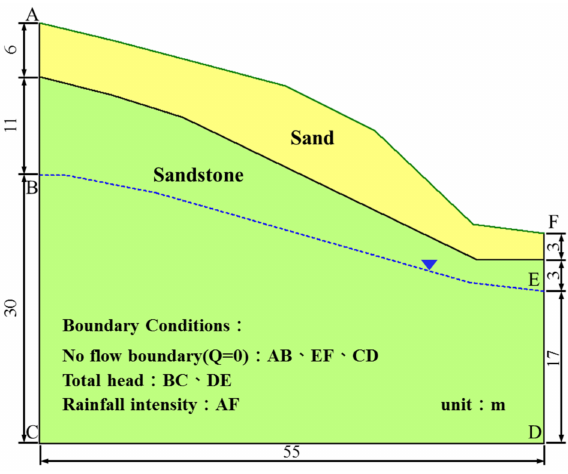
Figure 2. Slope model of Nan-Laio-Yeh-Hsi